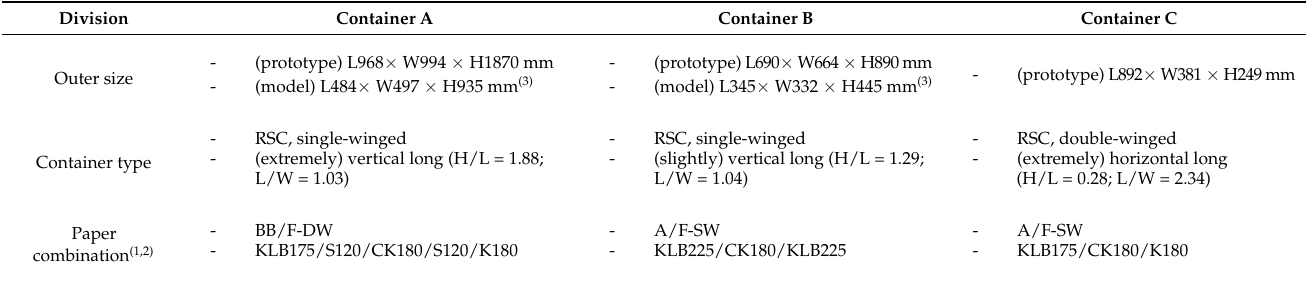
Table 2. Specifications of the shipping containers used for the target packages [14].